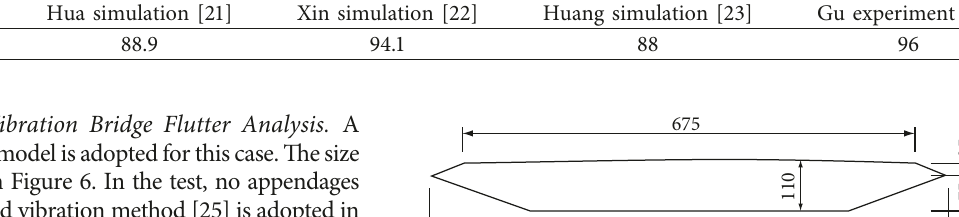
Table 5: Critical wind velocity U